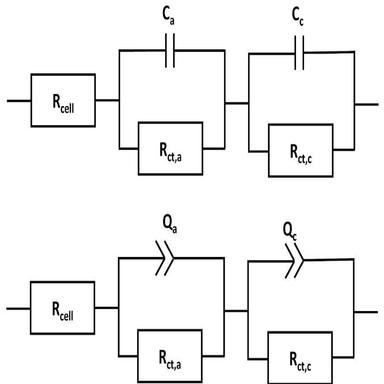
Equivalent circuit models of an alkaline water electrolyser with 2D-electrodes.